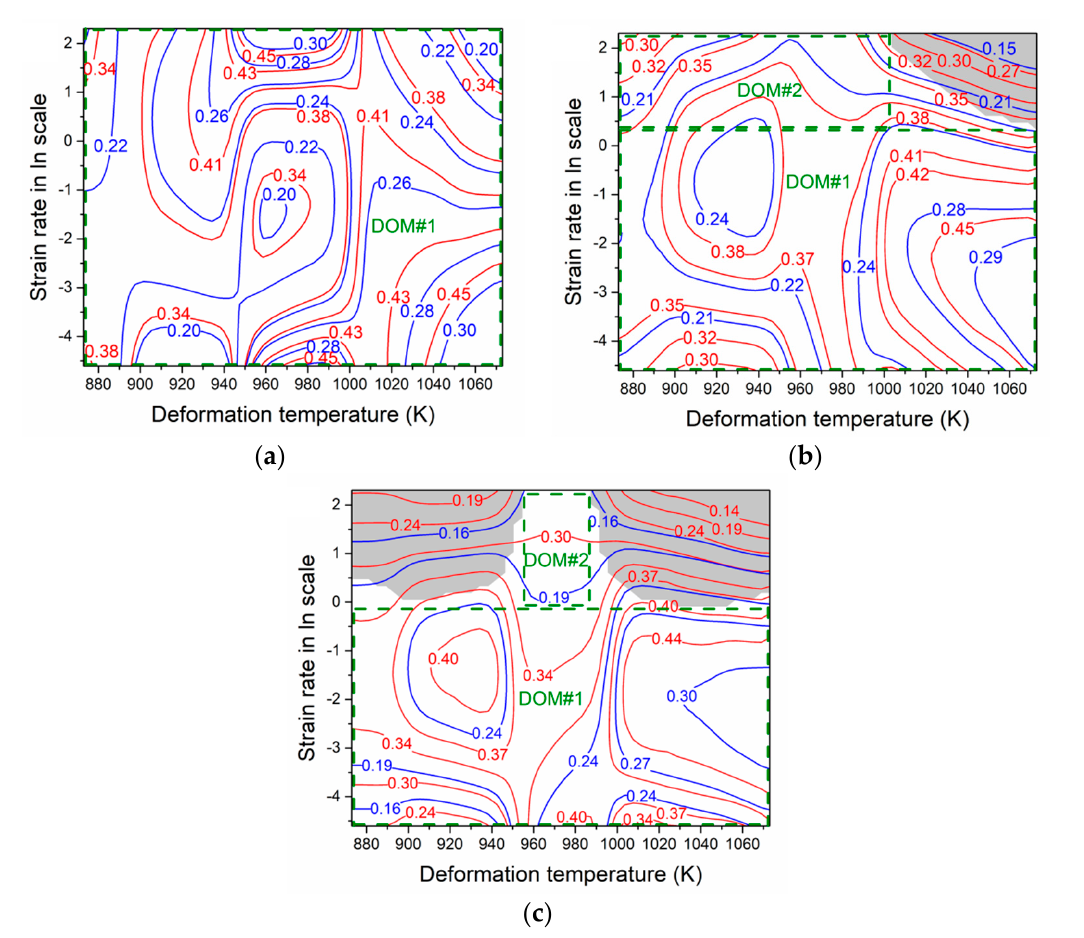
Figure 10. The processing maps consisting of strain rate sensitivity, power dissipation coefficient, and instability region ( a ) strain at 0.3, ( b ) strain at 0.6, ( c ) strain at 0.9.